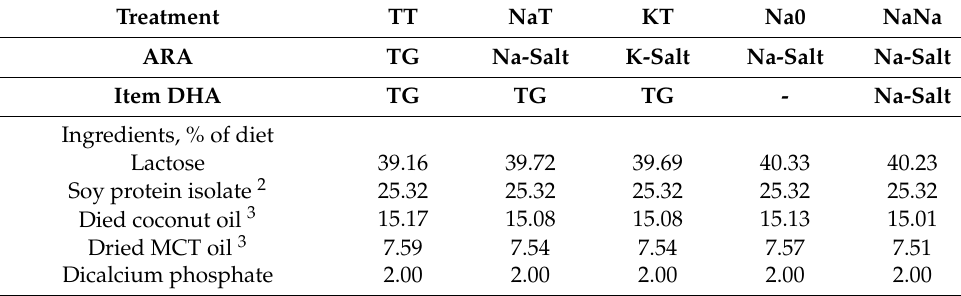
Table 1. Ingredient and nutritional composition of MR powders 1